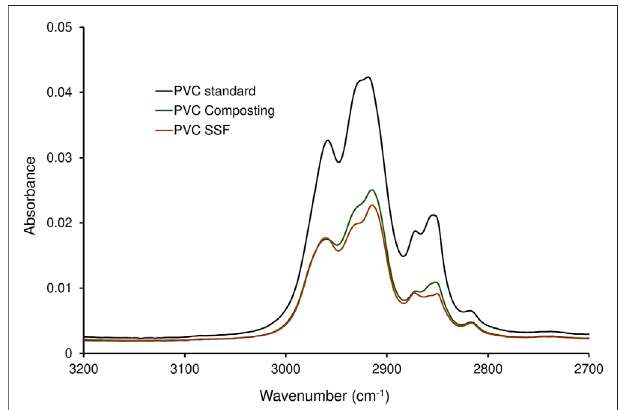
FIGURE 4 | Spectra of C-H stretch vibrations region of PVC treated in a two-stage degradation procedure by composting ( fi rst stage, 42 days; PVC Composting) and by B. amyloliquefaciens (second stage, 68 days; PVC SSF) compared to virgin PVC